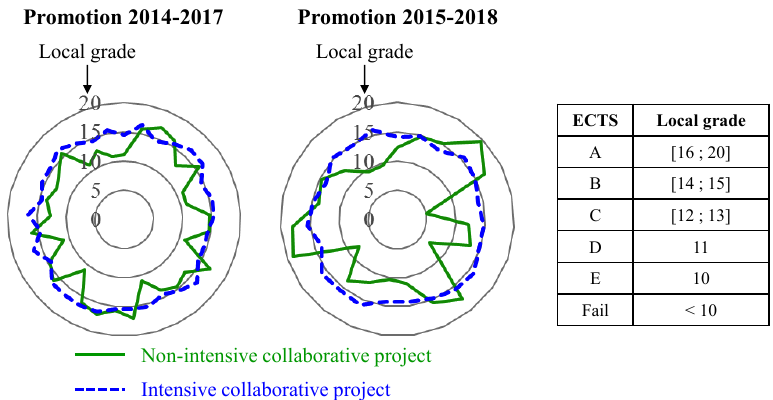
Fig. 4. Comparison with a Traditional PBL Approach (non-intensive collaborative project) ! On average, the students’ performances are very positive, whatever the PBL ap- proach. For example, regarding the Promotion 2014-2017, using the traditional PBL method, the mean local grade was equal to 13.9 (it corresponds to an ECTS grade equal to “C”). The intensive collaborative PBL method scored about 15.5 (it corresponds to an ECTS grade equal to “B”). So, these results seemed a little bet-